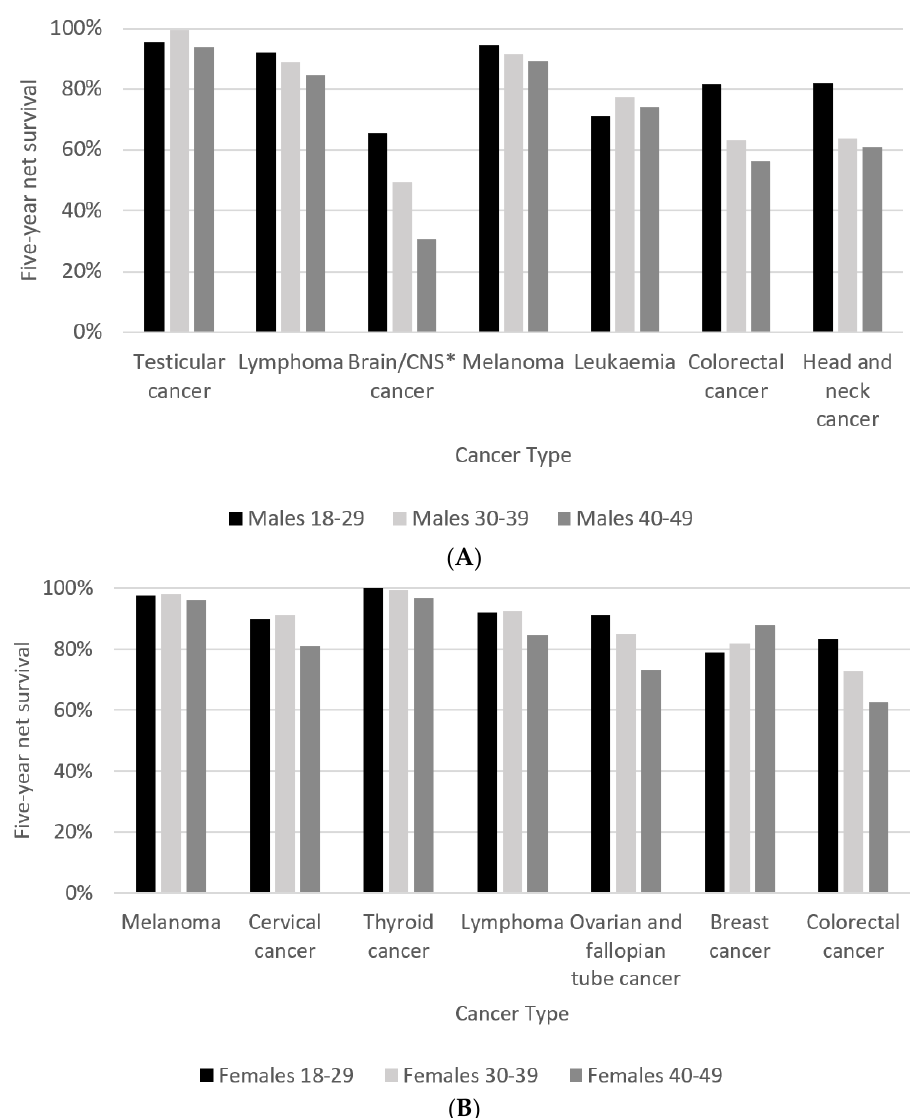
Figure 4. ( A ) Five-year net survival for males by age group diagnosed in 2000 – 2014, followed up to end of 2019. Cancer types displayed are the cancers common to all three age groups in males. * central nervous system; ( B ) five-year net survival for females by age group diagnosed in 2000 – 2014, followed up to end of 2019. Cancer types displayed are the cancers common to all three age groups in females.